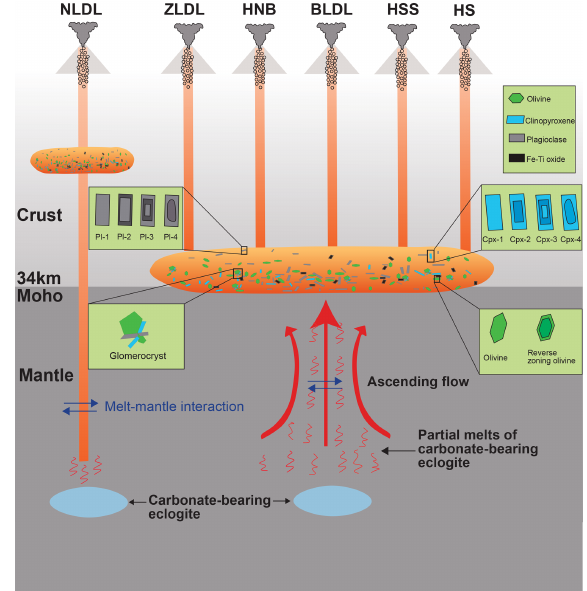
Figure 13. Schematic diagram of the magma plumbing systems be- neath the Wulanhada Volcanic Field. Melt with a slightly higher de- gree of partial melting ( ∼ 10%–20%) of carbonate-bearing eclogite ( ∼ 3wt%; Gt / Cpx = 2 / 8) is mixing with the relatively low degree of partial melting ( ∼ 5%) of garnet peridotite. Mixing melt ascends to the Moho depth that crystallizes olivine, clinopyroxene, plagio- clase and Fe–Ti oxide with conditions of ∼ 9–10kbar (33–36km) and ∼ 1100–1160 ◦ C. The magmatic reservoirs in the Moho depth supply magmas for Beiliandanlu, Zhongliandanlu, Heinaobao, Hu- oshaoshan and Hongshan. With a difference, the primary melt of Nanliandanlu interacts with the mantle, which changes the melt composition during ascent from source to surface. Modified melt as- cends to the middle crust depth that crystallizes olivine, clinopyrox- ene, plagioclase and Fe–Ti oxide with conditions of ∼ 6.0–6.7kbar (23–26km) and ∼ 1100–1160 ◦ C. The relatively shallow magmatic reservoir supplies melt for Nanliandanlu. The injection of melt from the mantle source into the two magmatic reservoirs results in the complex mineral textures and triggers the eruption